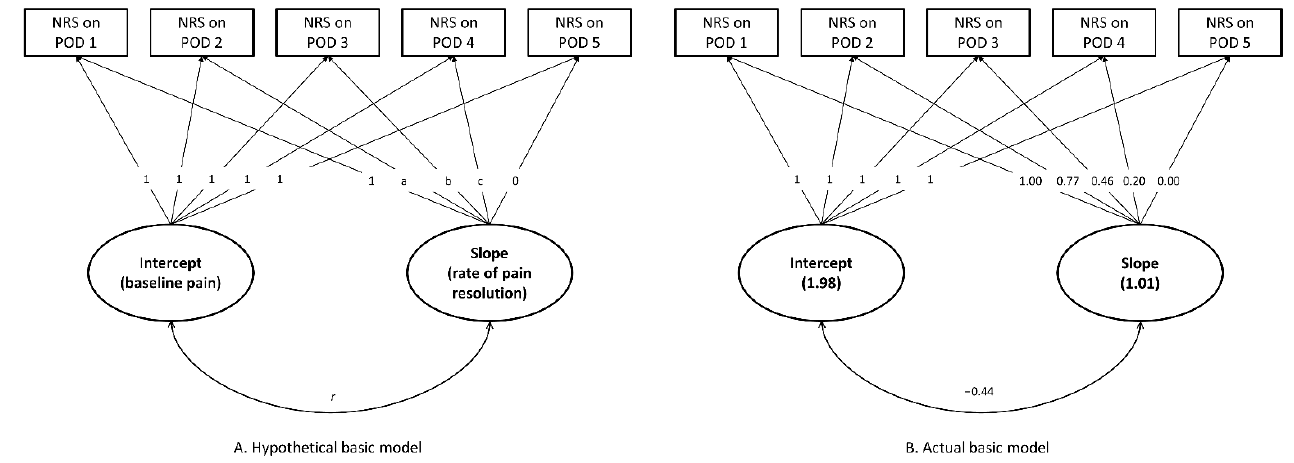
Figure 1. The basic latent curve model for pain trajectories after surgery for renal cell carcinoma. (A) Hypothetical basic model. (B) Actual basic model.